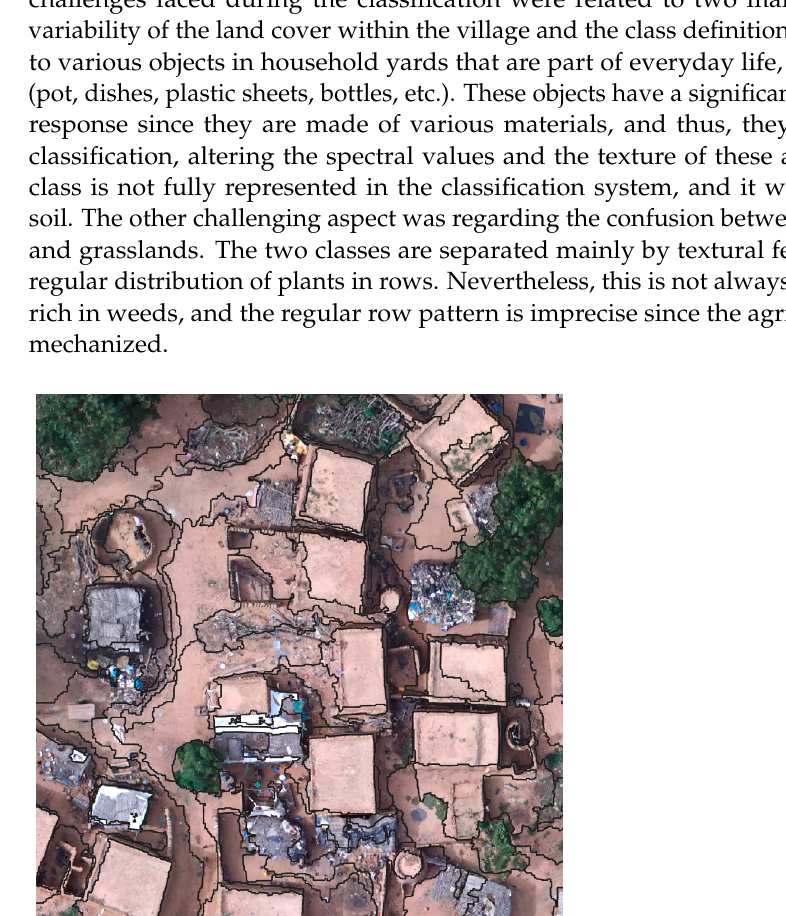
Figure 11. Example of land cover spectral variability within households’ yards.